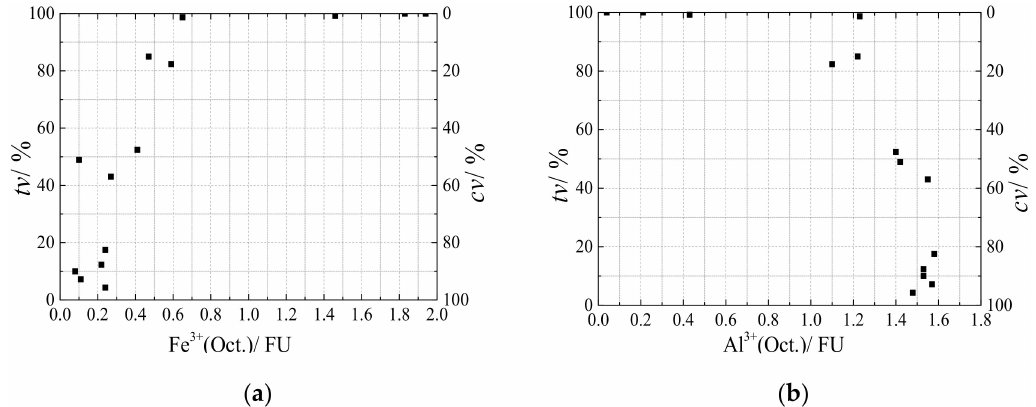
Figure 11. Relationship of the proportion of tv and cv layers to ( a ) octahedral Fe 3 + content and ( b ) octahedral Al 3 + content.